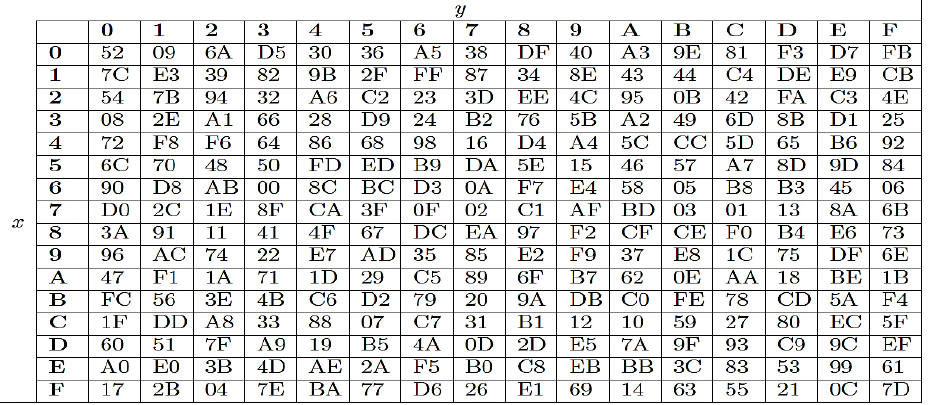
Figure 3. Sbox involved in Inverse substitute bytes transformation.